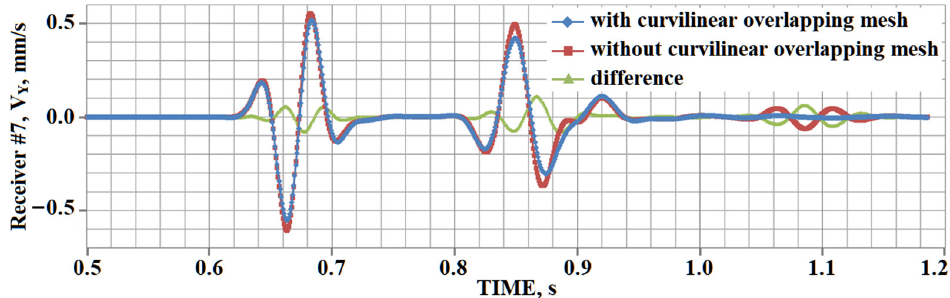
Figure 17. Receiver #7, dependencies of Y-component of velocity on time.